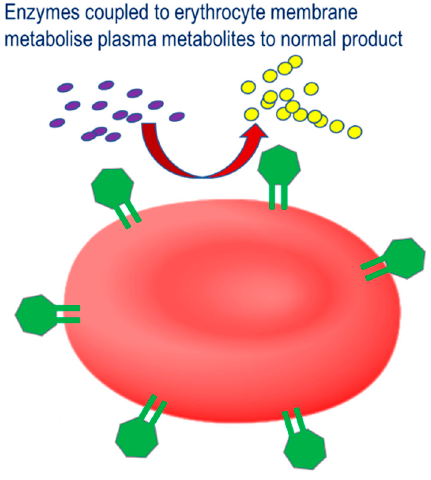
Figure 3. Therapeutic strategy for therapeutic enzymes coupled to the erythrocyte membrane. Pathological plasma metabolites are catalyzed by the conjugated enzyme to their corresponding non-pathological product.